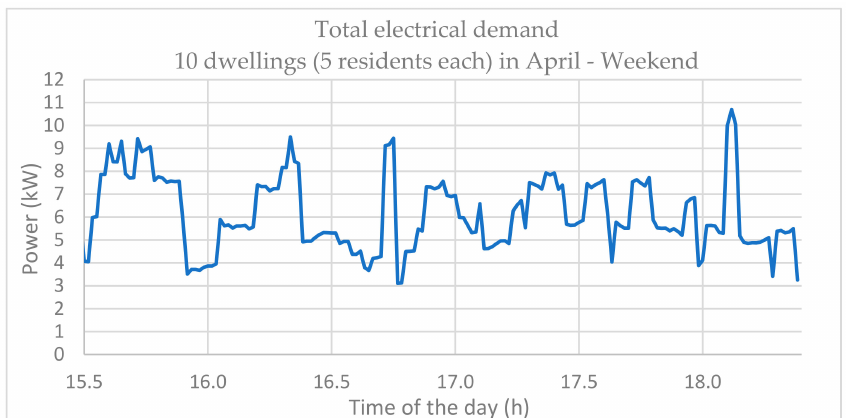
Figure 14. 3 h (15:30–18:30) total electrical demand—Profile